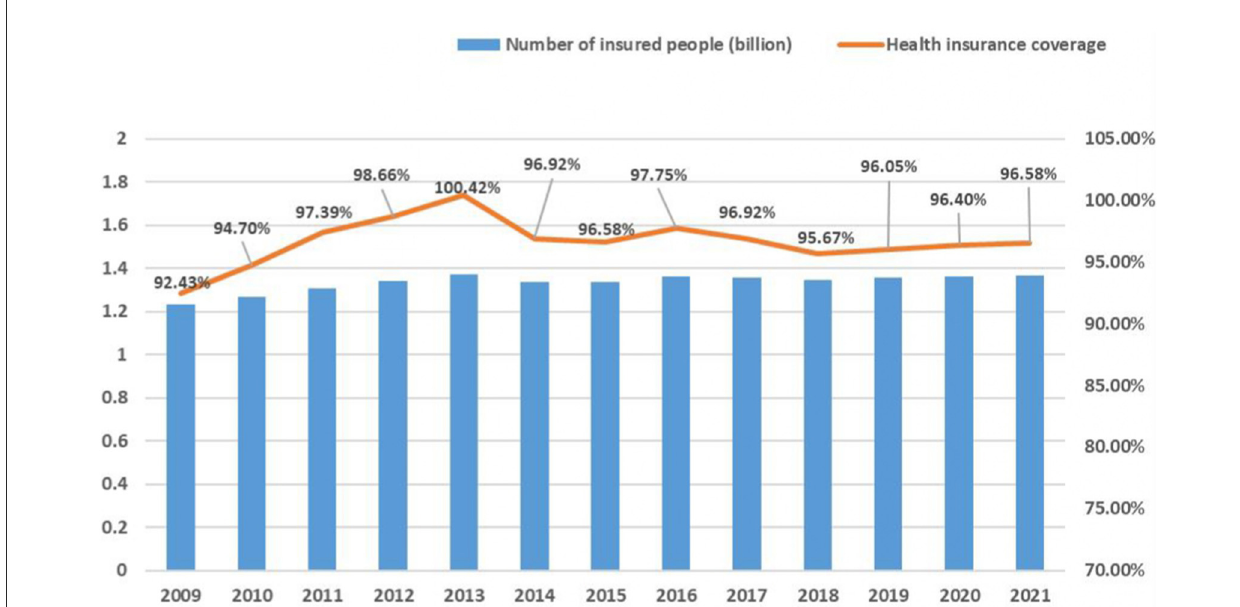
FIGURE1 Trend of health insurance coverage in China from 2009 to the present. In 2013, due to the duplication of statistics on the number of participants in the New Rural Cooperative and urban medical insurance, the total number of people covered by the national medical insurance was high, and if duplicate statistics were excluded, the participation rate would still be above